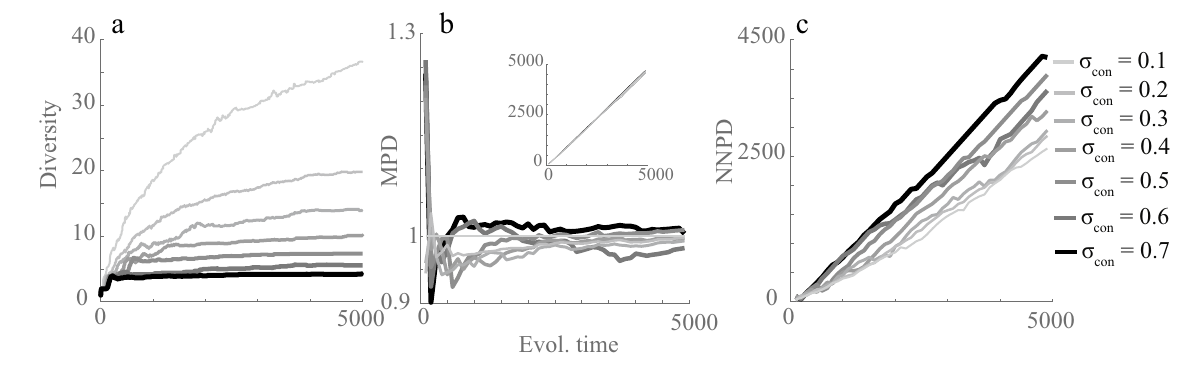
Figure 4. Diversity ( a ), mean phylogenetic trait distance (MPD) ( b ) and nearest neighbor phylogenetic distance (NNPD) ( c ) as a function of evolutionary time and niche widths (σ con ). MPD in ( b ). is scaled using σ con = 0.1 as reference and the y-axis thus shows the change factor of MPD at different σ con values compared to the σ con = 0.1 baseline. Insert in ( b ). show non-scaled MPD values as a function of evolutionary time and σ con , indicating a low variation among σ con –scenarios and a monotonic increase in MPD with time. All results are shown as means over 20 simulation replicates (see variation across replicates in Fig. S1). Model parameters that were kept constant for the simulations were: K 0 = 10,000; σ K = 1; r = 1; µ = 0.01; σ µ = 0.02. Figure produced in MATLAB version